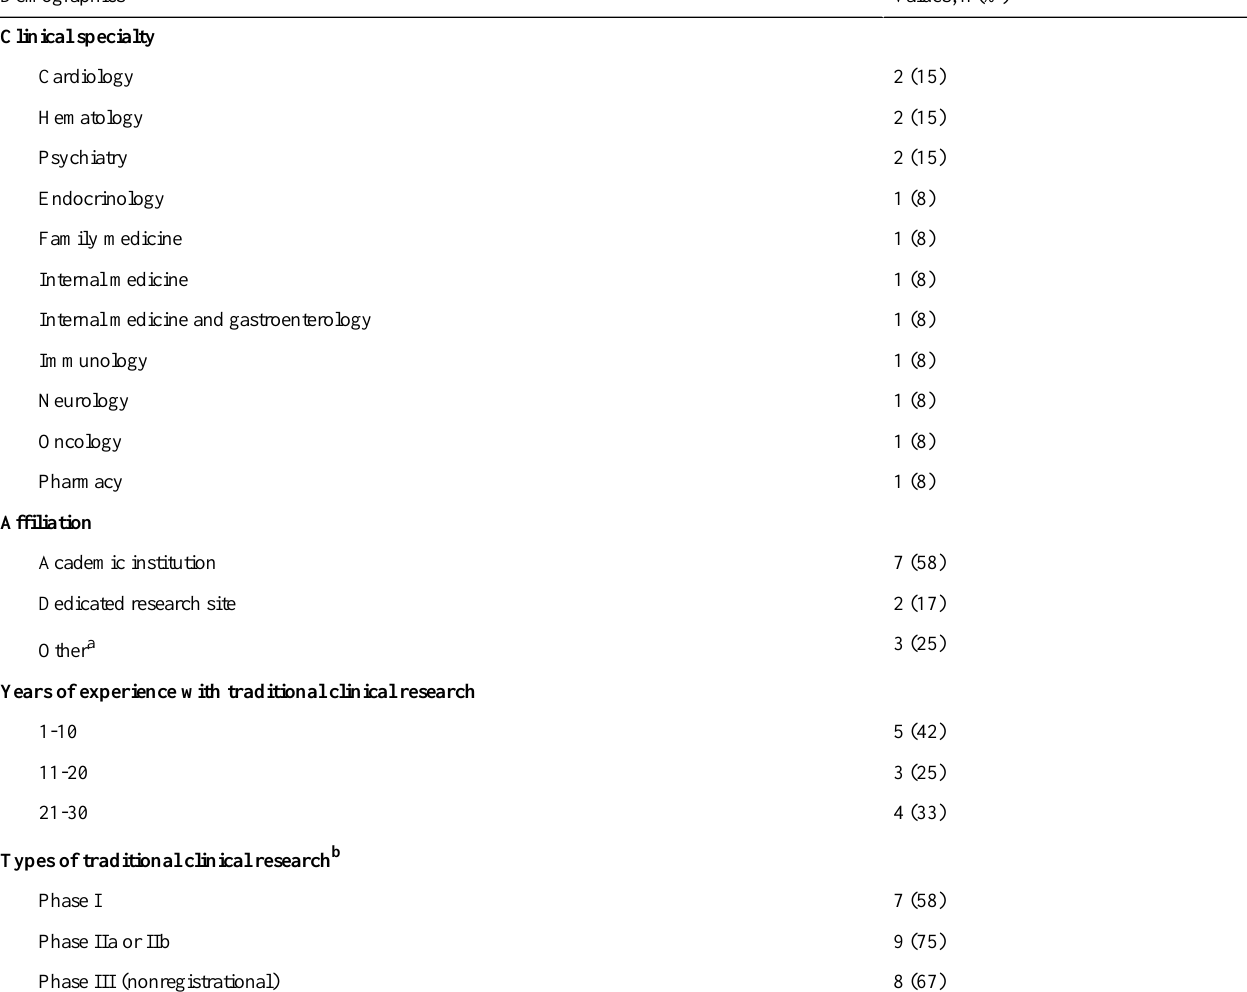
Table 1. Investigator demographics